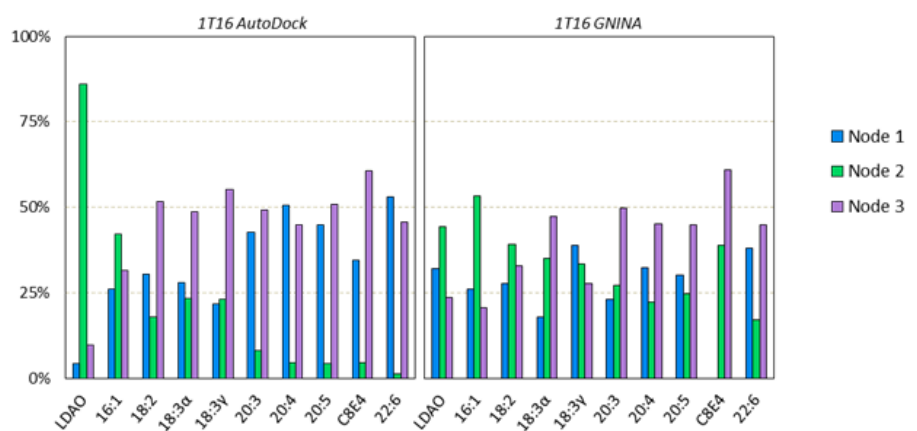
Figure 5. Charts of the percent of each ligand in proximity to each node between the AutoDock and GNINA dockings. Node 1 represents the low affintity binding site, Node 2 the high affinity binding site, and Node 3 the S3 kink. There were a total of 500 poses per ligand type docked.